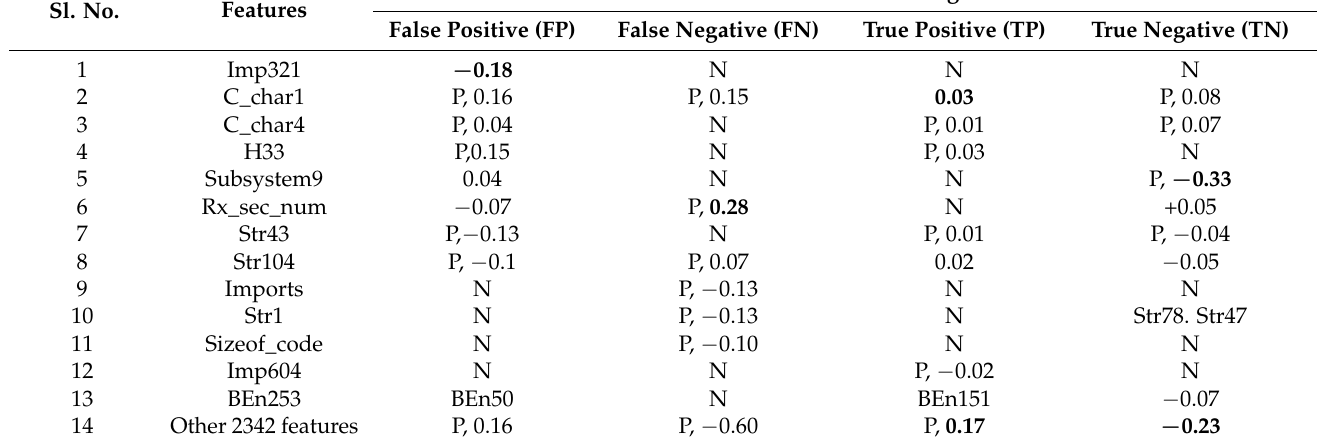
Table 11. Comparison of features and their probability scale value in all predicted categories by XGBoost model. Bold means topmost